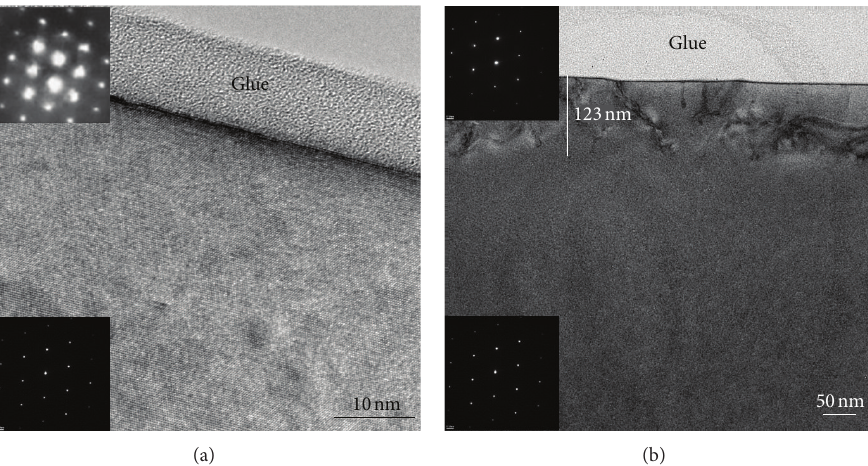
Figure 3: TEM and ED pattern of the two implanted and PLM processed samples; (a) corresponds with the single implanted while (b) corresponds with the double implanted samples.